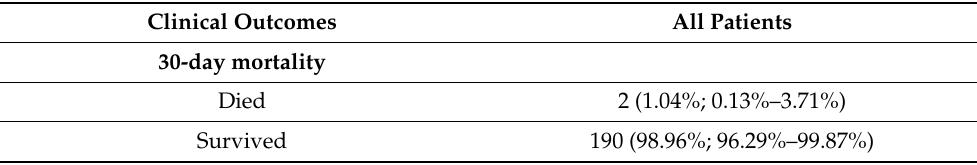
Figure 3. Associations between the change in lipid levels and surgical characteristics, stratified ac ‐ cording to statin therapy. Table 3. Clinical outcomes. Nominal values present total number of patients for a particular clinical endpoint, with distribution of the interquartile range as a